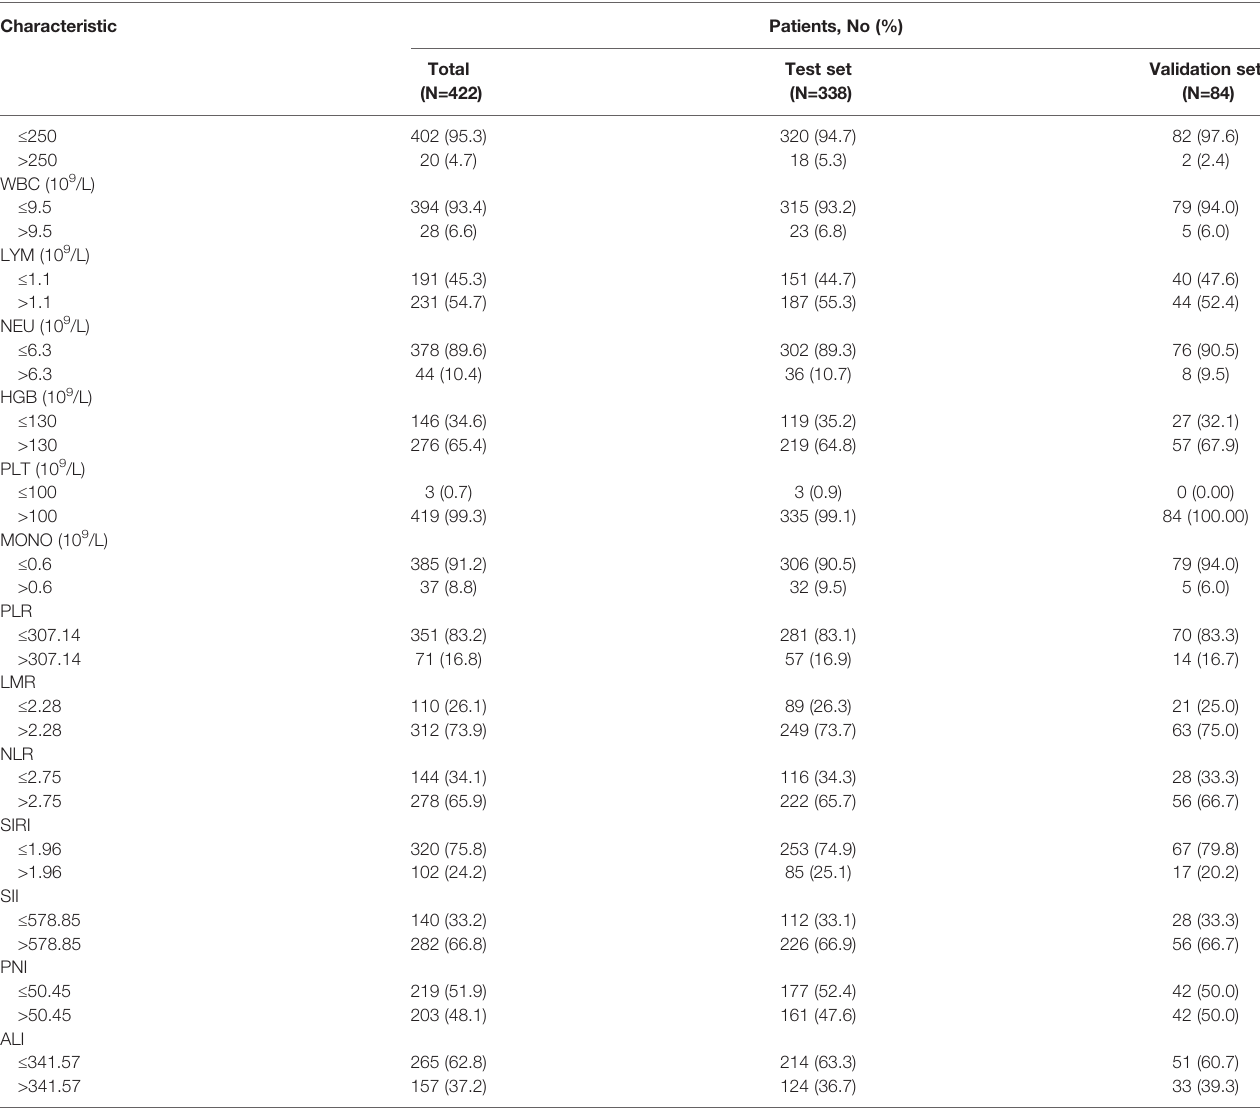
within one standard error from the minimum ( l .1se) to